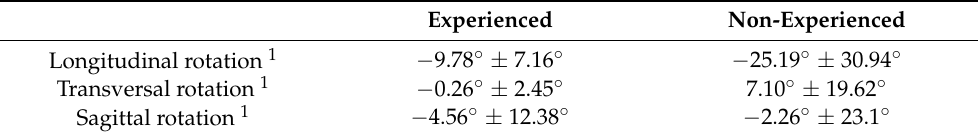
Table 3. Difference in angular orientation between the initial and retracted defensive position hook